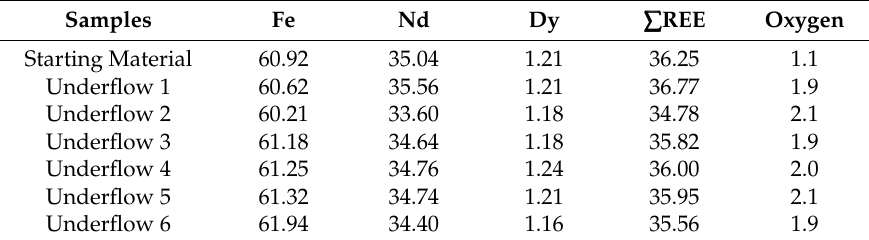
Table 4. Chemical analysis of underflow streams in weight